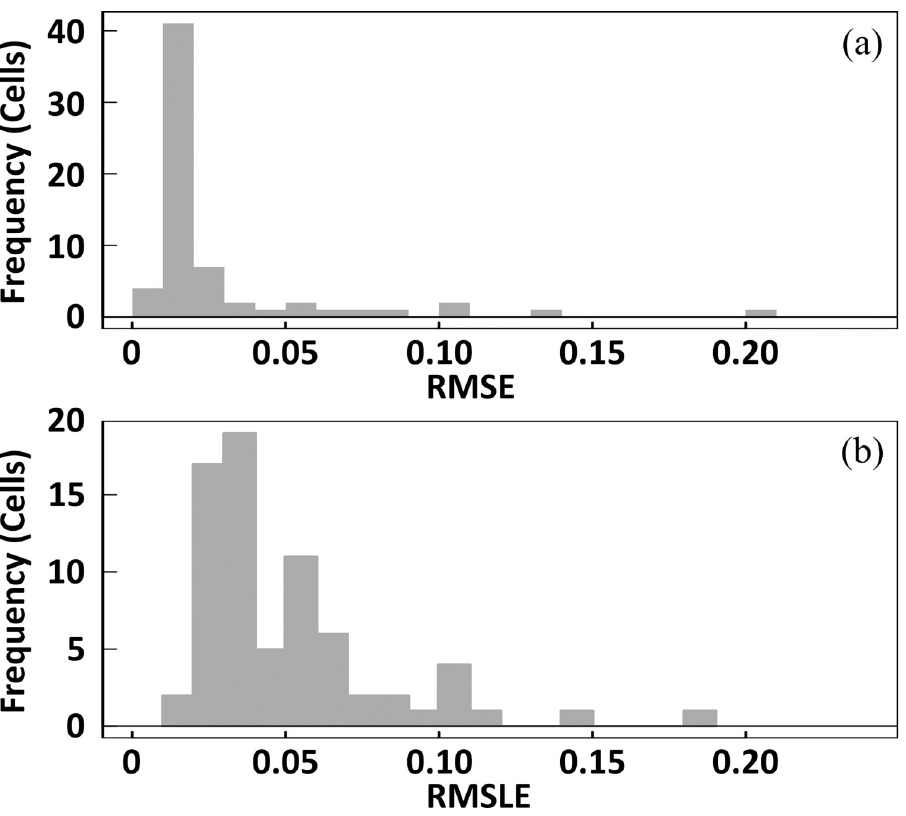
Fig 2. Histograms of (a) RMSE and (b) RSMLE in the illuminated and dark I–V curve fittings, respectively.